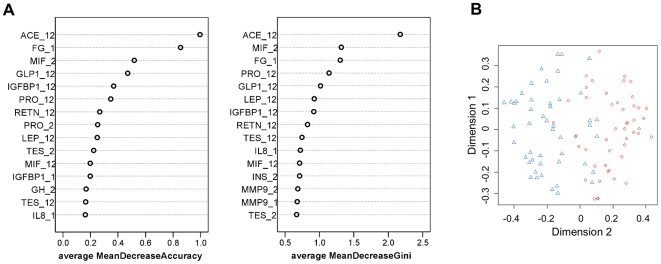
Top 15 important predictors for weight loss maintenance identified by Random Forest.
A. The variables are ranked by the average of 10 runs on the mean decrease in classification accuracy (MDA) or by the mean decrease in classification Gini impurity (MDG). Suffix “_1”: concentration at CID1, “_2”: concentration at CID2, “_12”: fold change of the concentration (CID2/CID1). The symbol of blood analytes are listed in
Table 1. B. Classification plot of continued weight-losers (red dots) and weight-regainers (blue triangles) during weight maintenance in pooled subjects (n = 96) by the top15 important variables.